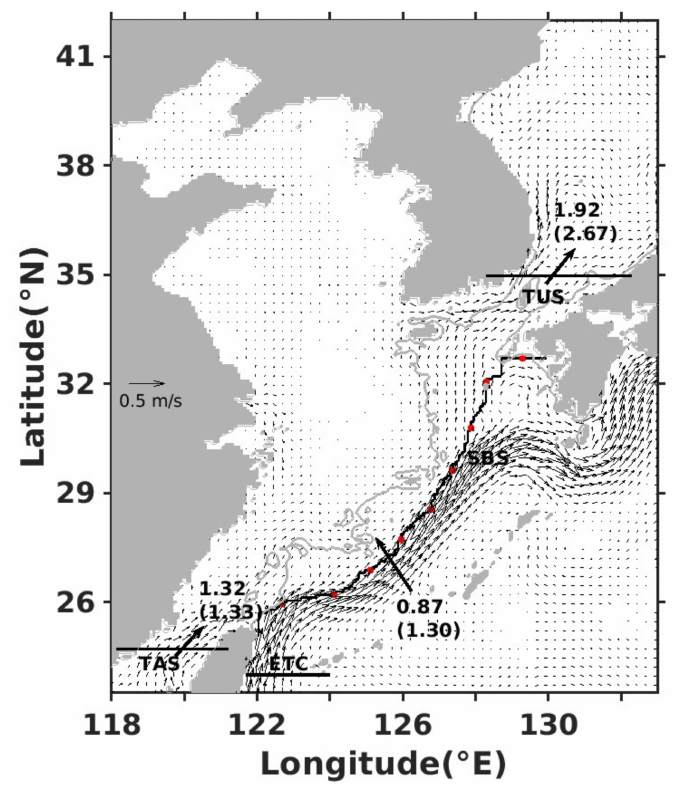
Figure 1. Annual-mean sea surface current distribution in the Bohai Sea, Yellow Sea, and East China Sea (BYECS, black arrows). The study region (BYECS) is closed with three lines indicating the Taiwan Strait (TAS), shelf break section (SBS, 200-m isobath), and Tsushima Strait (TUS). Between each set of adjacent red dots on the black lines, there are 20 grid points. The grid points are counted from south to north. Arrows across these black lines represent heat (volume) transport across the sections measured in × 10 14 W (Sv, × 10 6 m 3 s − 1 ). Gray contour lines represent the 100-m isobaths, the Kuroshio enters the East China Sea from the East Taiwan Channel